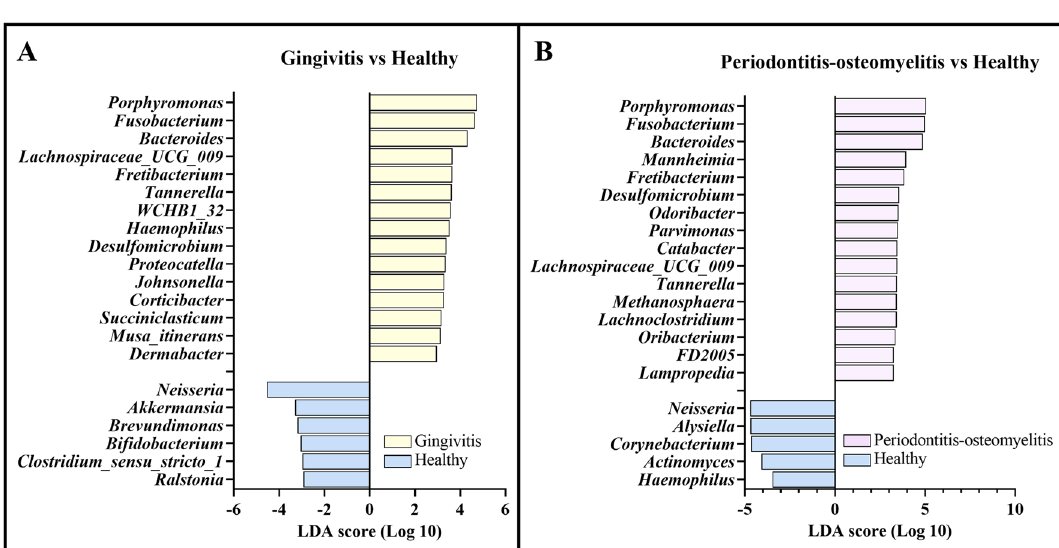
Figure 5. Biomarker discovery in macropod progressive periodontal disease using LEfSe test. ( A ) The main genera that differentiate gingivitis from healthy samples. ( B ) The main genera that differentiate periodontitis- osteomyelitis from healthy samples. LEfSe test with alpha value = 0.05 and threshold of absolute logarithmic linear discriminant analysis (LDA) score > 2. Higher absolute values of the LDA score represent higher enrichment and discriminative performance. Compared to healthy, Porphyromonas , Fusobacterium are overabundant in gingivitis and periodontitis-osteomyelitis samples. In contrast, Neisseria is underabundant in gingivitis and periodontitis-osteomyelitis